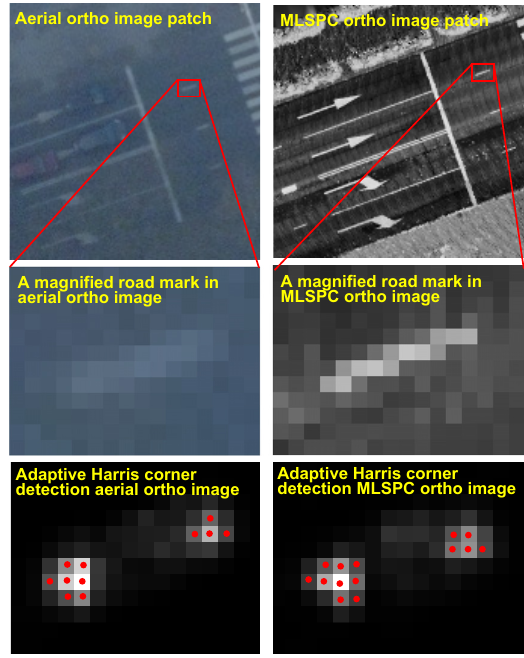
Figure 6. Example of adaptive Harris corner keypoint detection of a road marking, multiple keypoints (red dots) are detected over two observable corner.